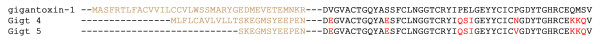
Comparison of sequences retrieved using motif 5 with gigantoxin-1 precursor (Q76CA1). Mature polypeptides are shown in black; signal peptides and propeptide domains are in light brown; amino acids that differ from the sequence of gigantoxin-1 are given in red.